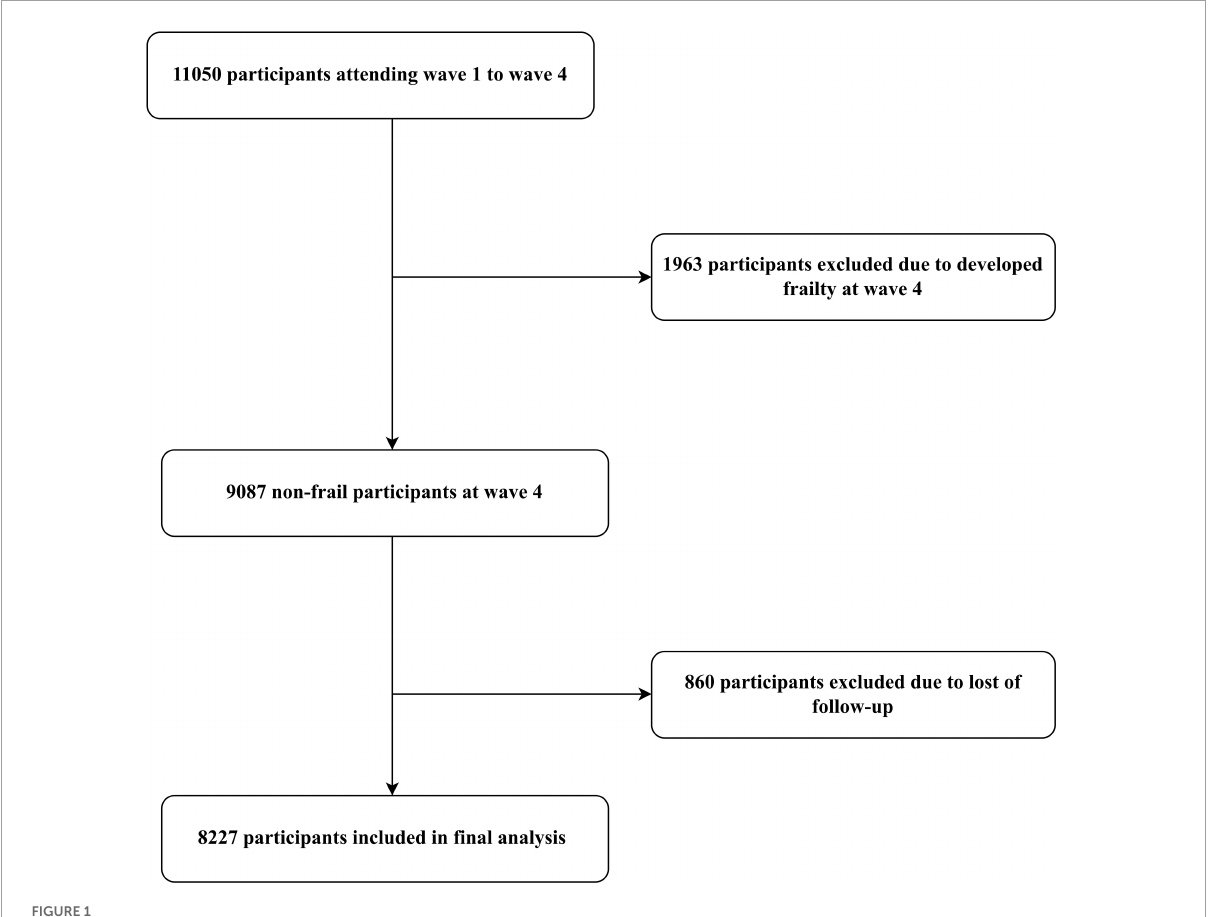
FIGURE1 Flow chart of participants